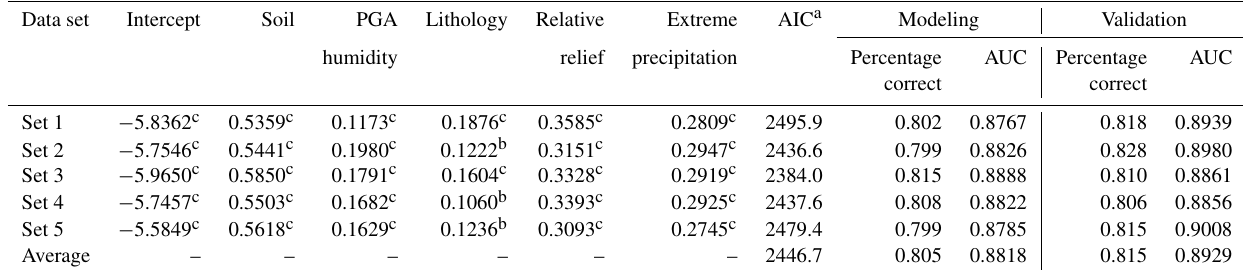
Table 6. Results of model based on global SRTM DEM (90m).